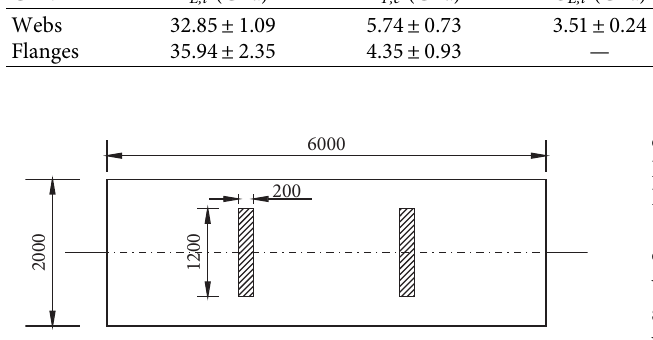
Figure 5: Loading deck area